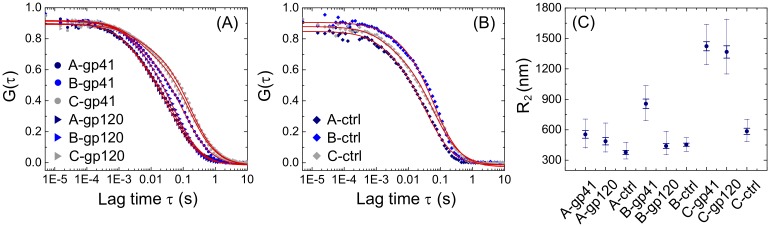
Fluorescence correlation spectroscopy reveals quantitative differences in virion aggregation.(A) Normalized experimental average ACFs recovered for native virus opsonized with anti-gp41 mAbs or HIVIG (A-gp41) or with anti-gp120 mAbs or HIVIG (A-gp120), gp41-coated virus opsonized with anti-gp41 mAbs or HIVIG (B-gp41) or with anti-gp120 mAbs or HIVIG (B-gp120), aggregated virus opsonized with anti-gp41 mAbs or HIVIG (C-gp41) or with anti-gp120 mAbs or HIVIG (C-gp120). (B) Normalized experimental average ACFs recovered for control groups consisting of the same virus preparations as in (A) but with no antibody or anti-dengue mAb. In both panels (A) and (B), only half of the total data points is shown for the sake of visual clarity, and the ACFs global fit to eq. S.4 (S1 Text) is shown with red continuous lines (all best-fit parameters are reported in S1 Table). (C) Hydrodynamic radius R2 of the aggregate population recovered for each group. Radii were computed based on the Stokes-Einstein equation (S1 Text) from the best-fit estimates of the diffusion coefficient D2. Thick error bars correspond to the standard deviations quantified by the rigorous error analysis of the ACF global fit as described in Materials and Methods. The same rigorous error analysis has also been exploited to yield, for each hydrodynamic radius, the minimum and maximum allowed values (thin error bars) compatible with one standard deviation of the ACF’s global-fit chi-square value. Results of the one-way ANOVA statistical analysis on the recovered radii are reported in S2 Table. All FCS experiments were conducted twice.